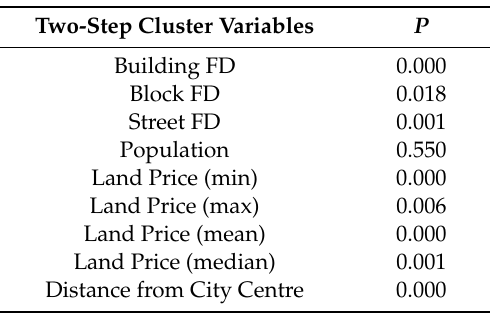
Table 2. Independent t -test significance results.